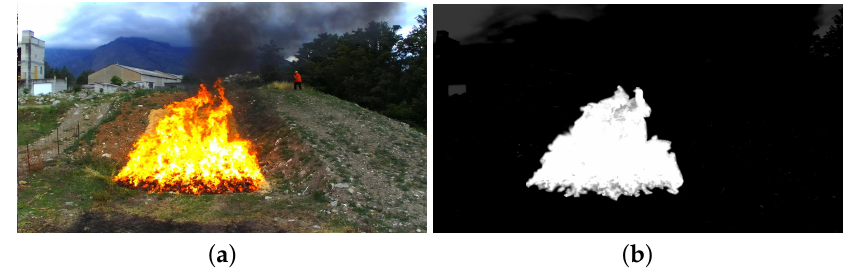
Figure 3. Example of images acquired simultaneously in the ( a ) visible and ( b ) long wavelength infrared